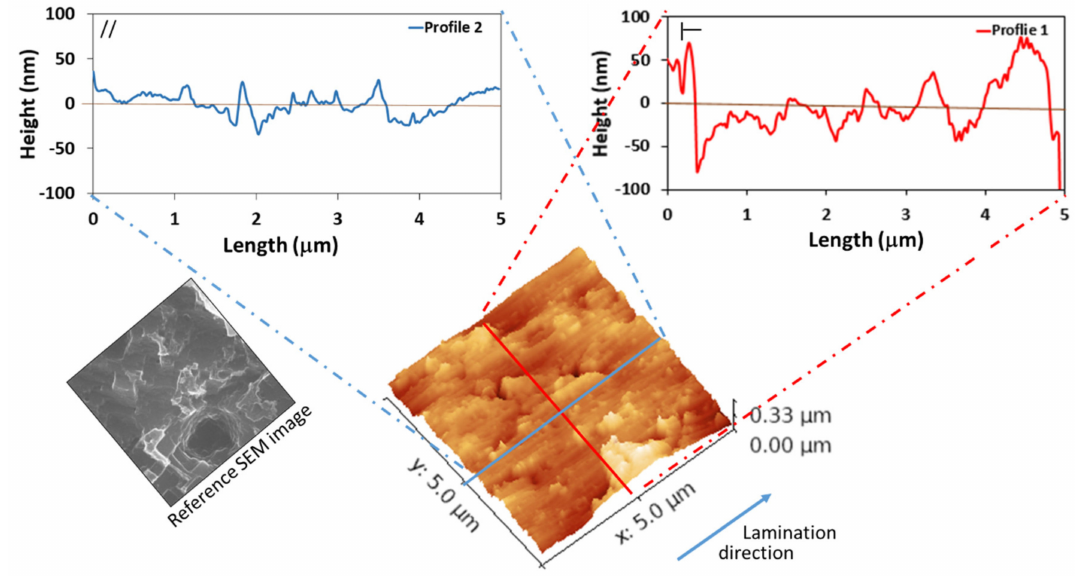
Figure 2. AFM image and typical height distribution histogram of as-received Al surface. Left , longitudinal direction; right , transversal